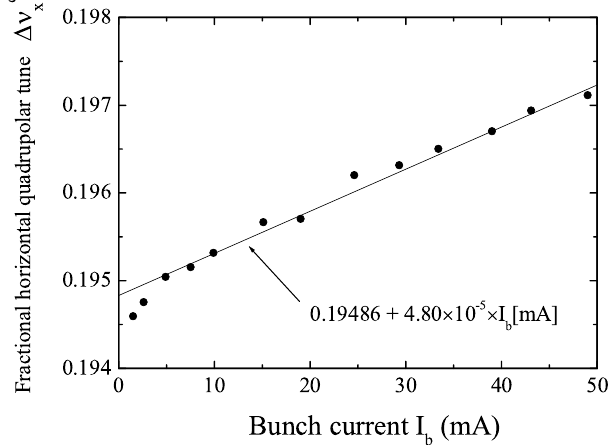
FIG. 3. Measured horizontal quadrupolar tunes as a function of the beam current per bunch. The solid line denotes the linear fit for the data, except for the first two points.